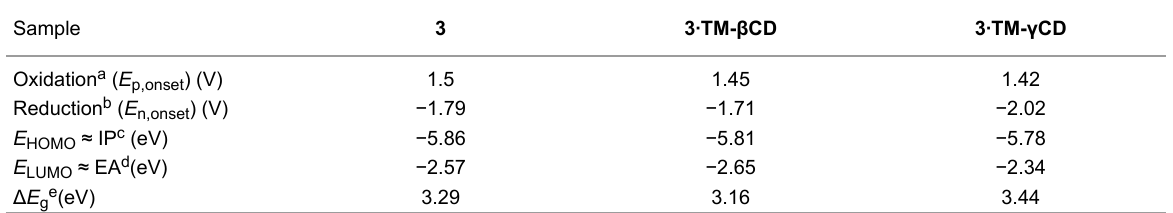
Table 2: The electrochemical data for 3 , 3·TM- β CD and 3·TM- γ CD copolymers.